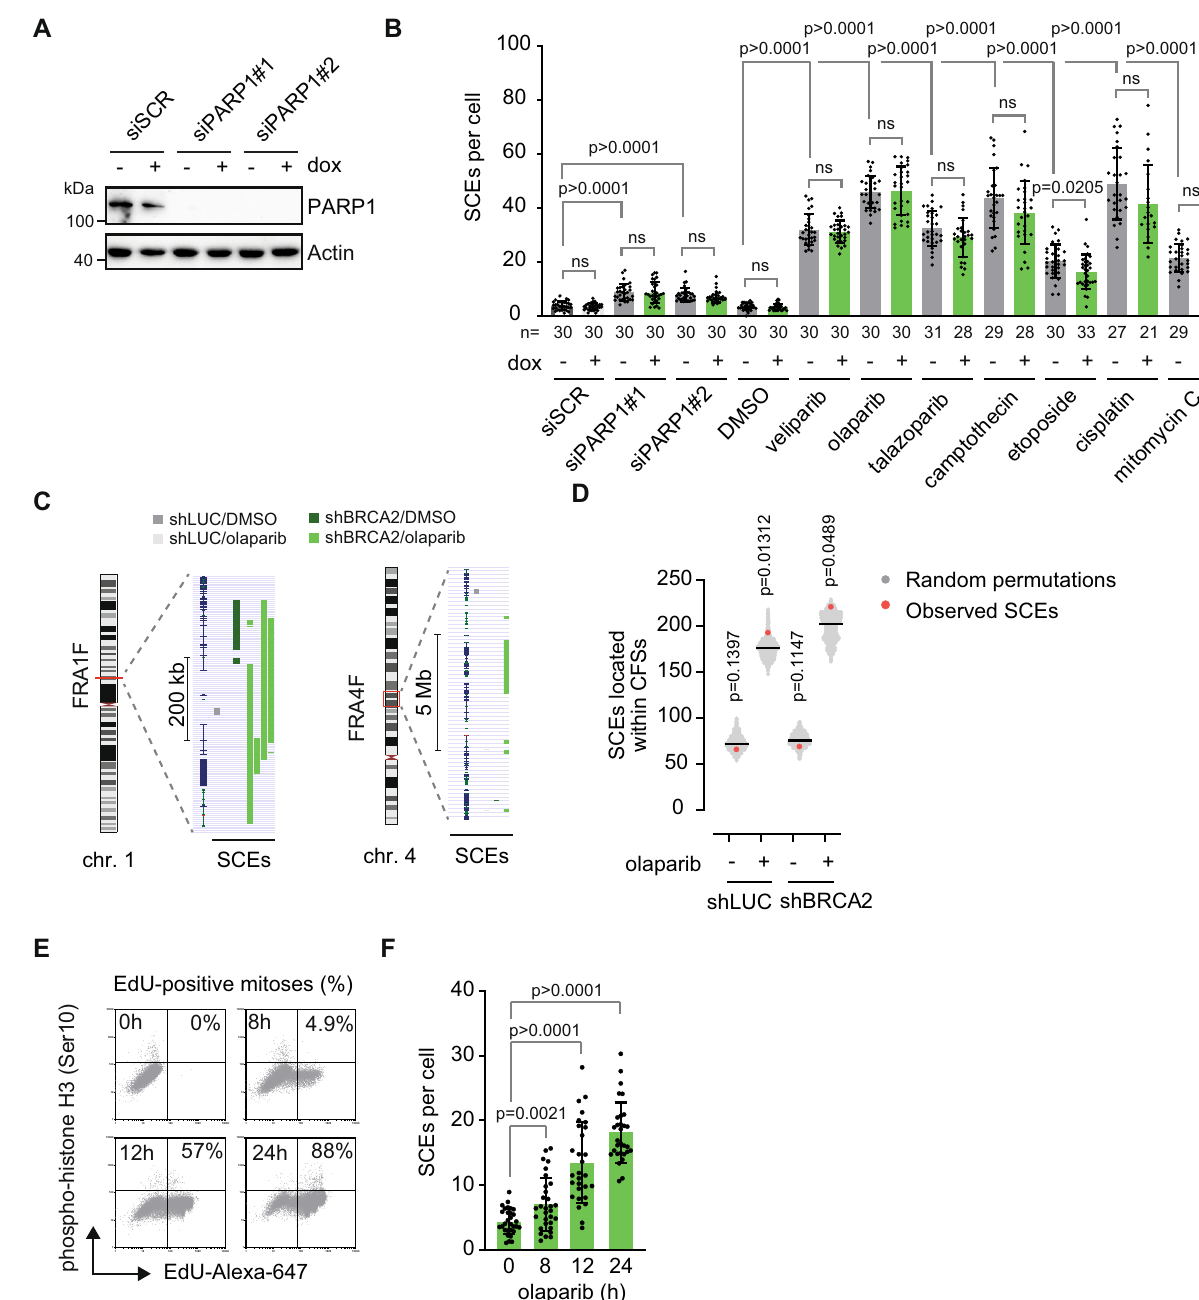
Fig.3|HR-independentSCEsareassociatedwithdefectivereplication.A RPE-1- TP53 -/- shBRCA2 cells werepre-treated withdoxycycline (dox)and transfected with siPARP or control siRNAs. Lysates were immunoblotted for PARP1 and Actin. Data are representative for two independent experiments. B RPE-1- TP53 -/- shBRCA2 cells were pre-treated with doxycycline (dox) and subsequently treated with indicated agents for 48h or transfected with PARP1 siRNAs 48h before harvest. SCEs were quanti fi ed by microscopy analysis of at least 21 metaphase spreads per condition from one biologically independent experiment. Exact n values are indicated in the graph. Averages and standard deviations areindicated. C , D KBM-7 cells harboring doxycycline-induciblecontrolorBRCA2shRNAswerepre-treatedwithdoxycycline and subsequently treated with olaparib where indicated. SCEs were mapped using StrandSeq of n =64 (shLUC/DMSO), n =31 (shLUC/OLA), n =50 (shBRCA2/DMSO), and n =52 (shBRCA2/OLA) libraries per condition from one biologically indepen- dent experiment. Observed SCEs were mapped to CFSs. Statistical analysis was